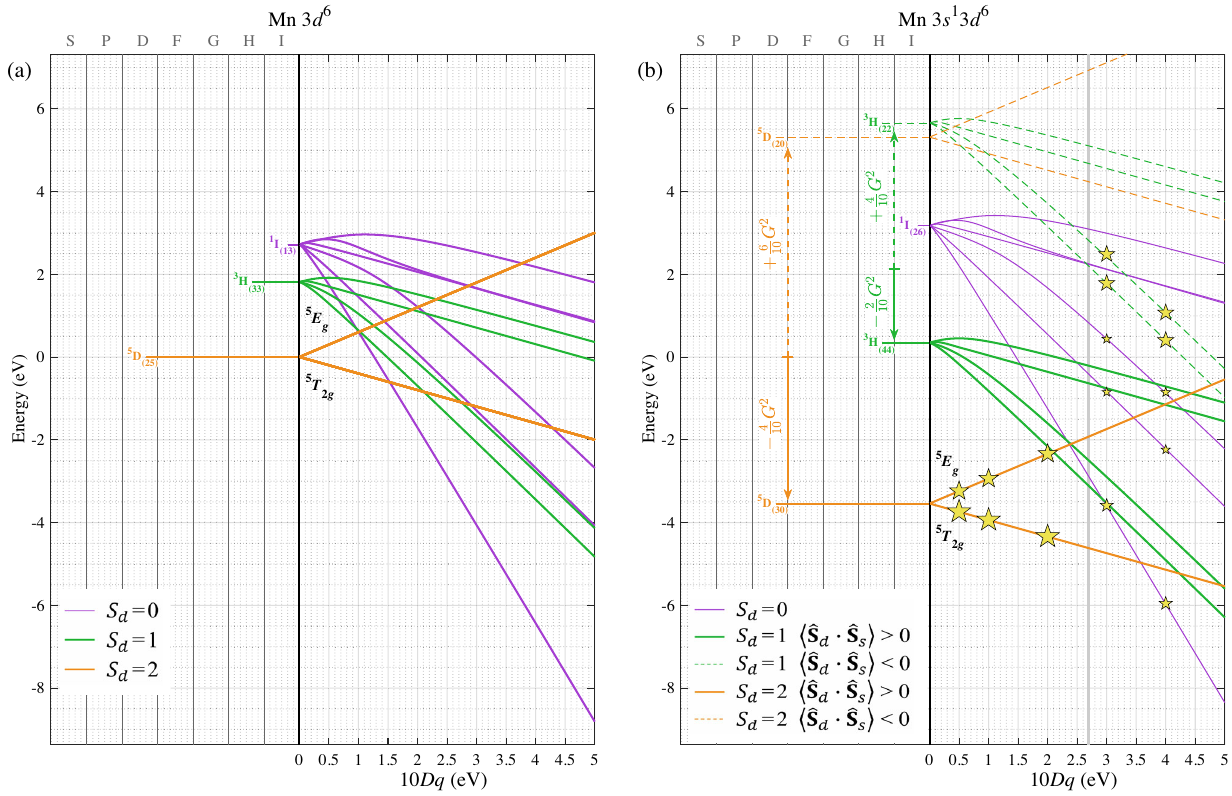
FIG. 9. Subsection of the modified Sugano-Tanabe-Kamimura diagrams represented in Fig. 5, showing only the multiplets relevant for s -NIXS spectroscopy for the (a) Mn 3 d 6 configuration (in absence of the core 3 s hole) and the (b) Mn 3 s 1 3 d 6 configuration (the s -NIXS final state). The vertical arrows in (b) indicate the rigid shift in energy of the states due to the interaction with the 3 s core hole.